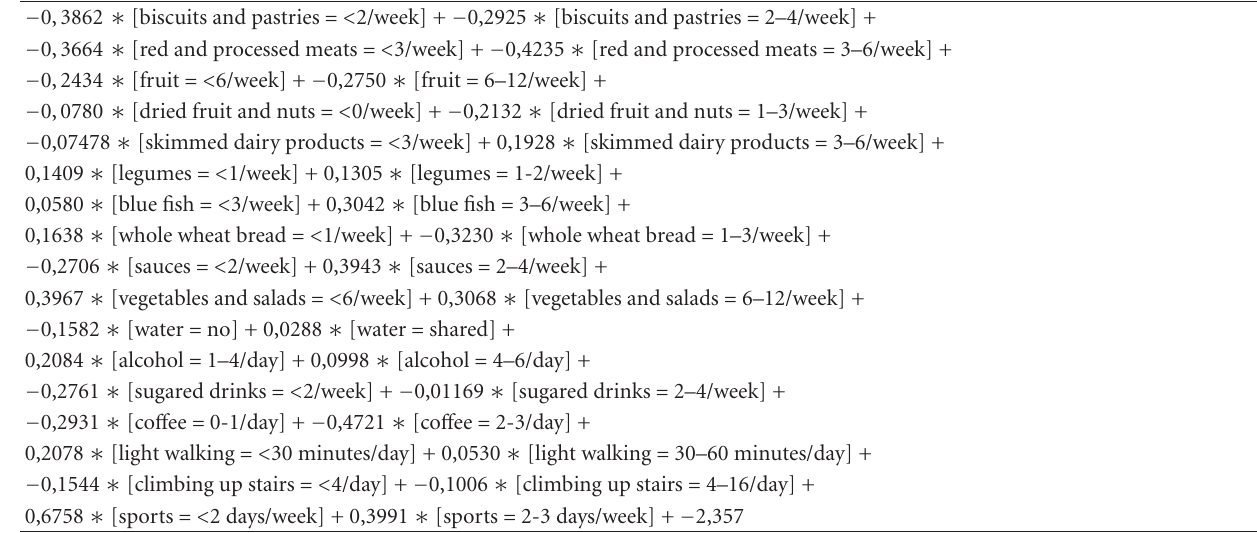
Table 3: Logistic regression equation for GDM = 1 using pregestational lifestyle